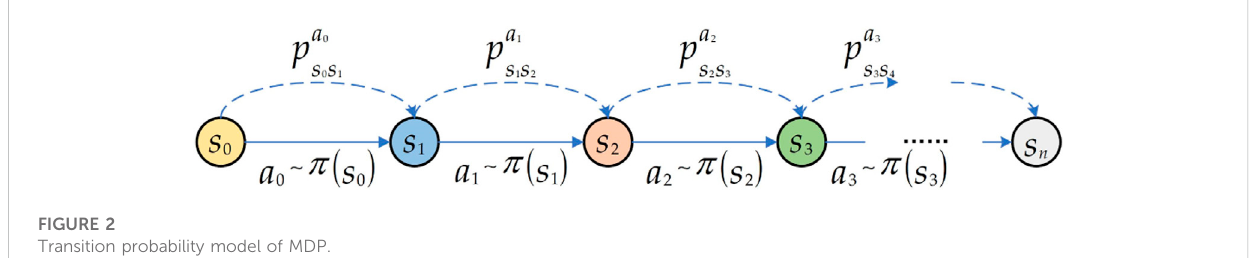
FIGURE 2 Transition probability model of